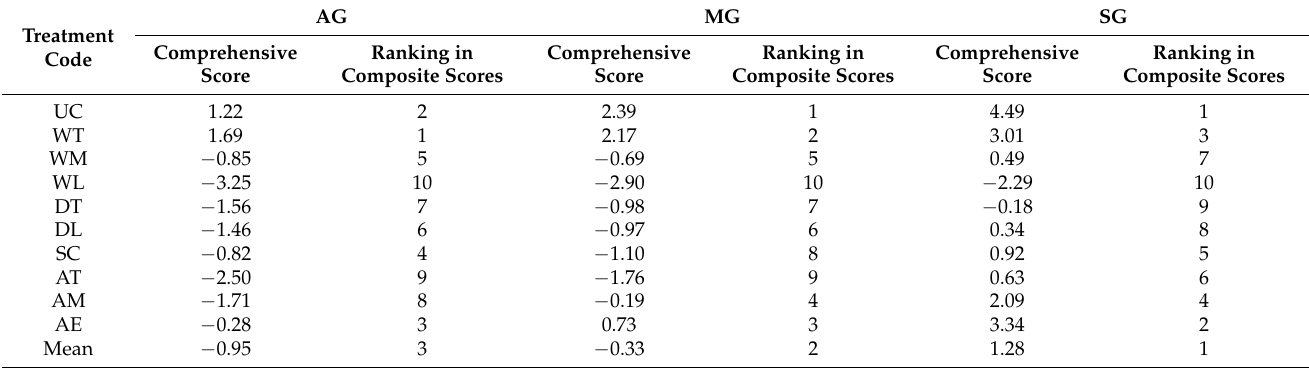
Table 4. Comprehensive scores of various parts of Benggang of different activity